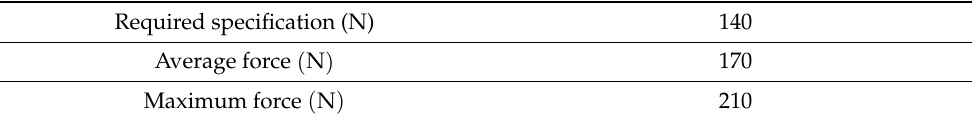
Table 2. Sowing force measurement